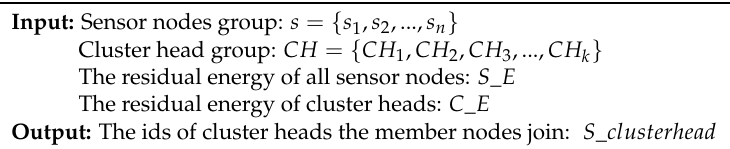
Algorithm 2: Cluster formation algorithm based on cluster head